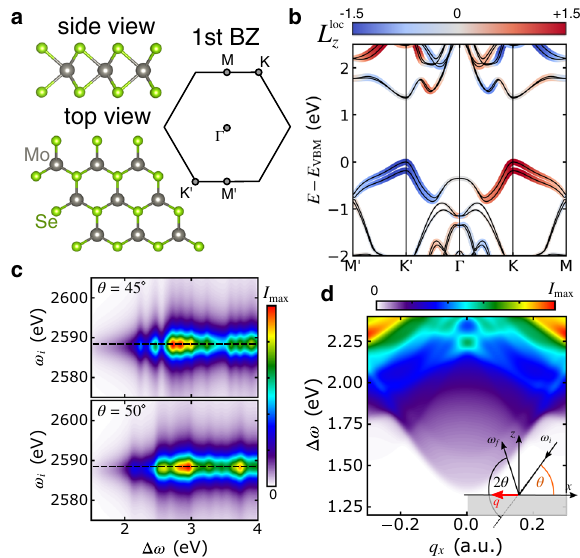
Fig. 2 Properties and RIXS spectrum of monolayer MoSe 2 . a Sketch of the lattice structure of MoSe 2 and the fi rst Brillouin zone, including the high-symmetry points. b Band structure relative to the valence band maximum (VBM) along the indicated path. The colored fat bands represent the weight of the Mo- d orbitals (size) and the local angular momentum (color map). c RIXS map showing the d - d particle-hole excitations at incidence angle θ = 45 ∘ (top) and θ = 50 ∘ (bottom panel). d Dispersion of the particle-hole excitations at fi xed incoming photon energy as indicated by the horizontal dashed line in c . The inset on the bottom right illustrates the geometry of the calculation: the angle 2 θ = 130 ∘ is fi xed, while varying θ corresponds to scanning over the in-plane momentum transfer q . The photon energy ω i is tuned to the L 2